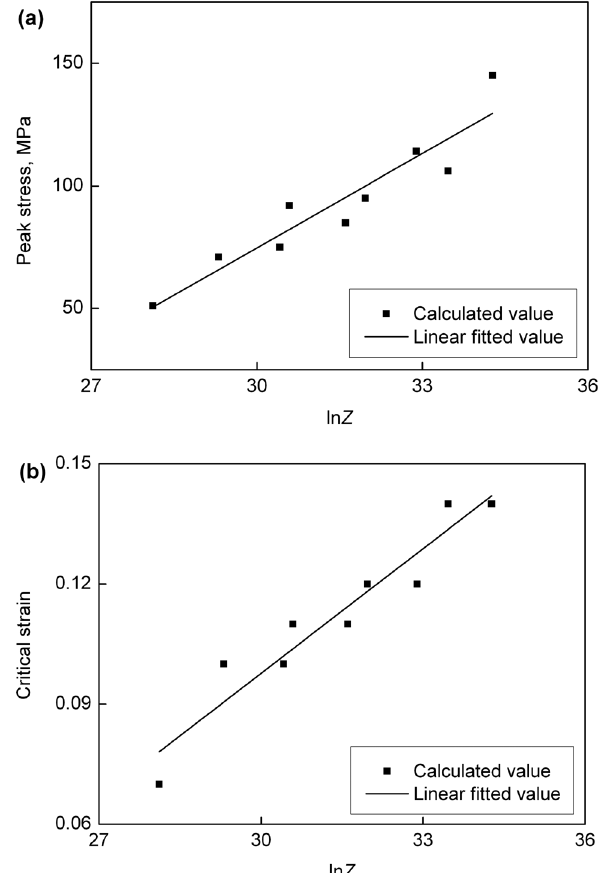
Fig. 10: Relationship between the (a) peak stress and (b) critical strain and natural logarithm of Zener-Hollomon